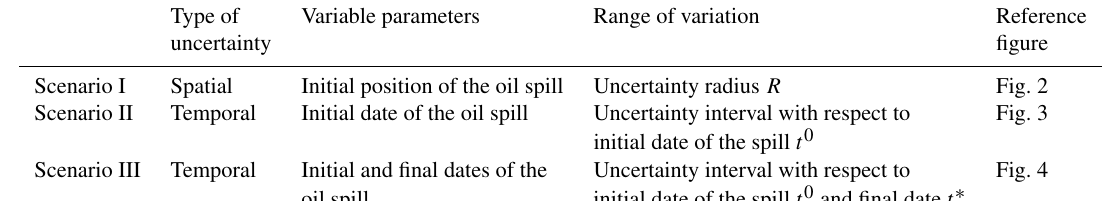
Table 2. Uncertainty scenarios implemented in WITOIL.